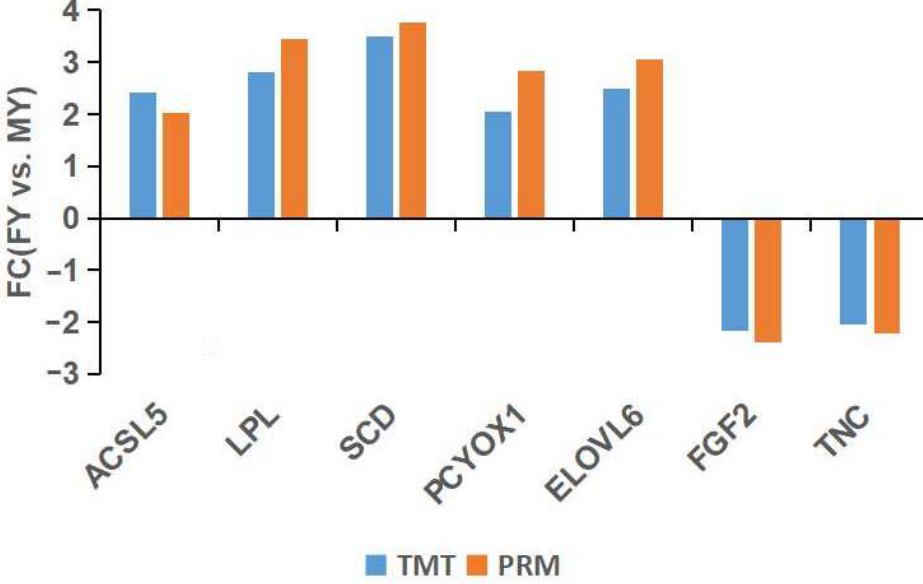
Figure 4. Validation and comparison of fold changes (FCs) in seven DEPs between parallel reaction monitoring (PRM) and the tandem mass tag (TMT) method.